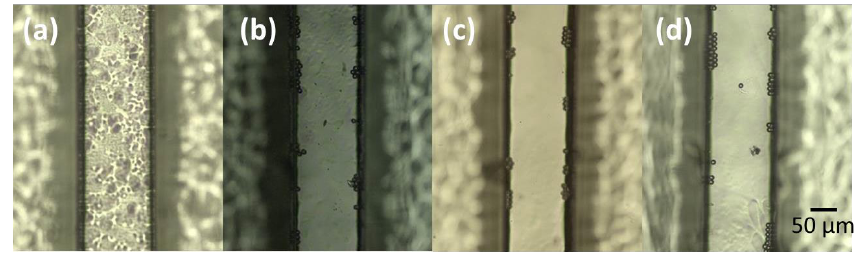
Figure 10. Microscope images of PMMA microinjected channels with no chloroform treatments ( a ) and with exposures times of ( b ) 2 minutes, ( c ) 4 minutes and ( d ) 6 minutes.